Question: Write a single sentence explaining what this figure depicts.
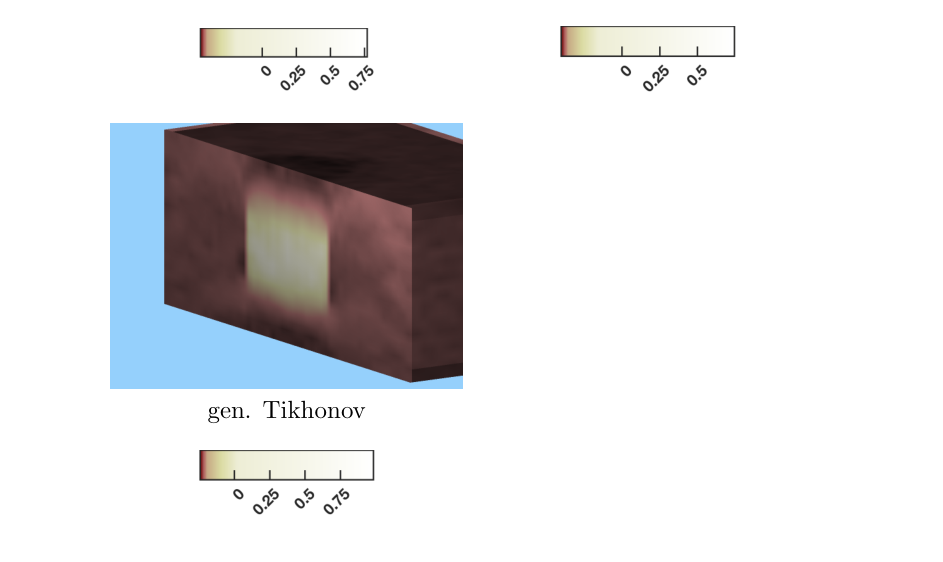
Answer: String reconstructions corresponding to lowest RRE for Example #3 via the considered methods for 5% noise with a = 0.05 and c = 0. The strings are sliced through the yt-plane to provide an interior viewpoint with the temporal direction of each of the strings increasing from the bottom of the figure to the top.